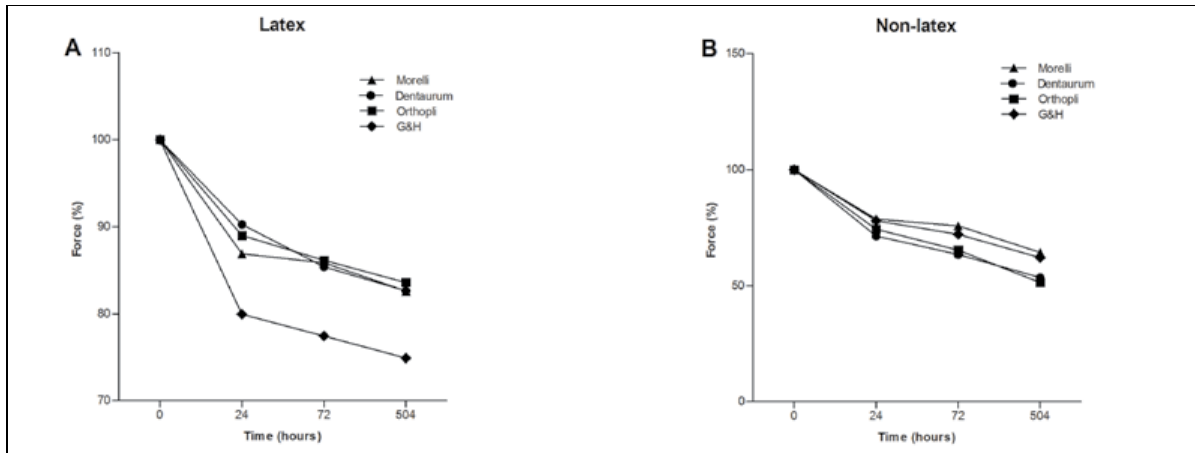
Figure 4. Comparison of the force degradation (%) of the latex (A) and the non-latex (B) elastics: Dentaurum, Orthopli, Morelli and G&H, in all experimental periods. p <